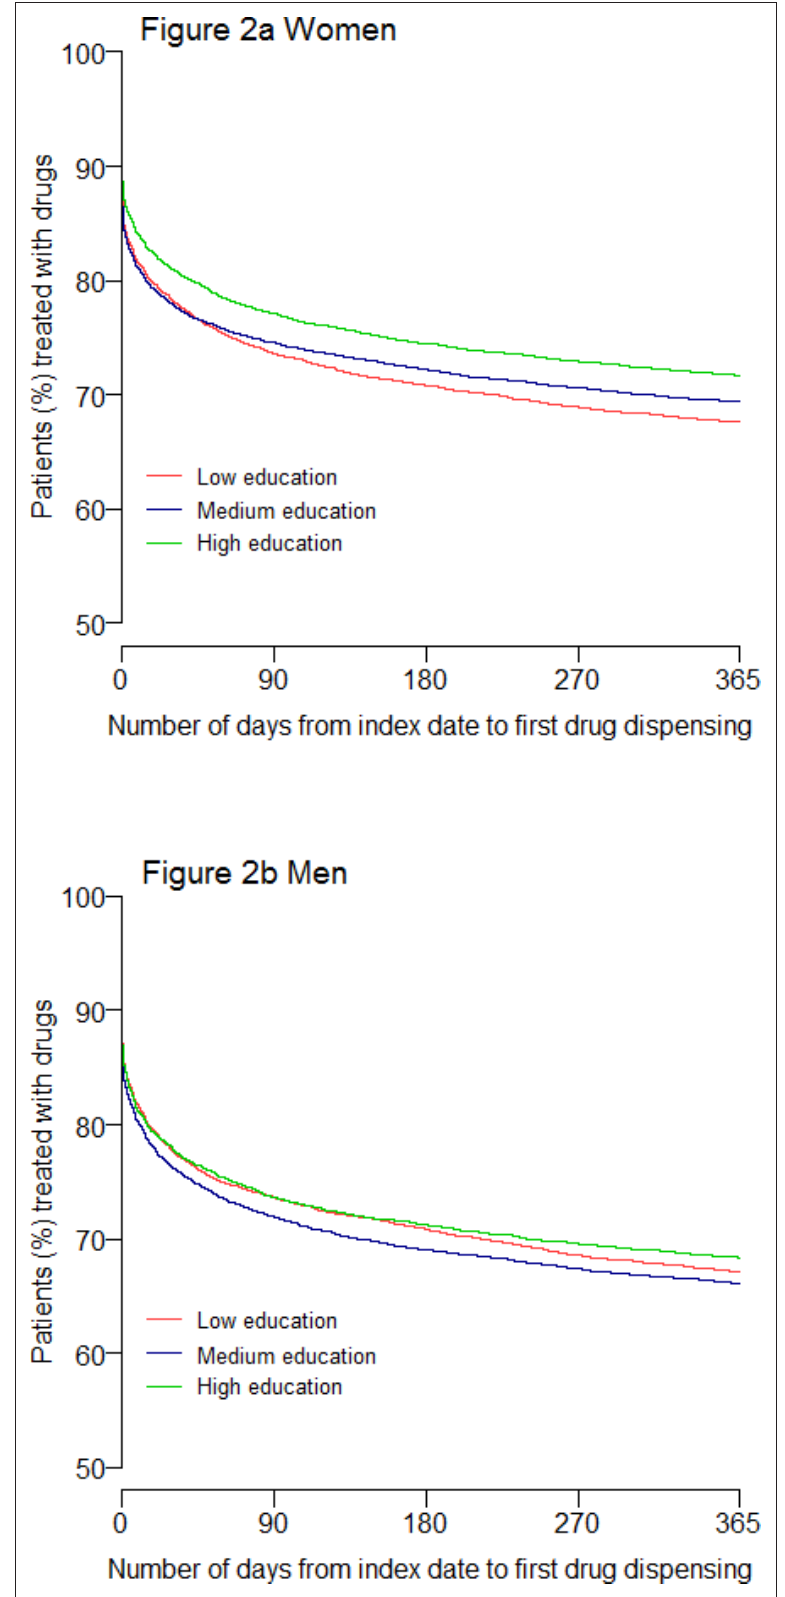
Figure 2 The association between education level and number of days from index date to first drug dispensing (Kaplan–Meier survival curves) for patients in Norway, aged ≥20 years with a new depression diagnosis in 2015 ( N = 49